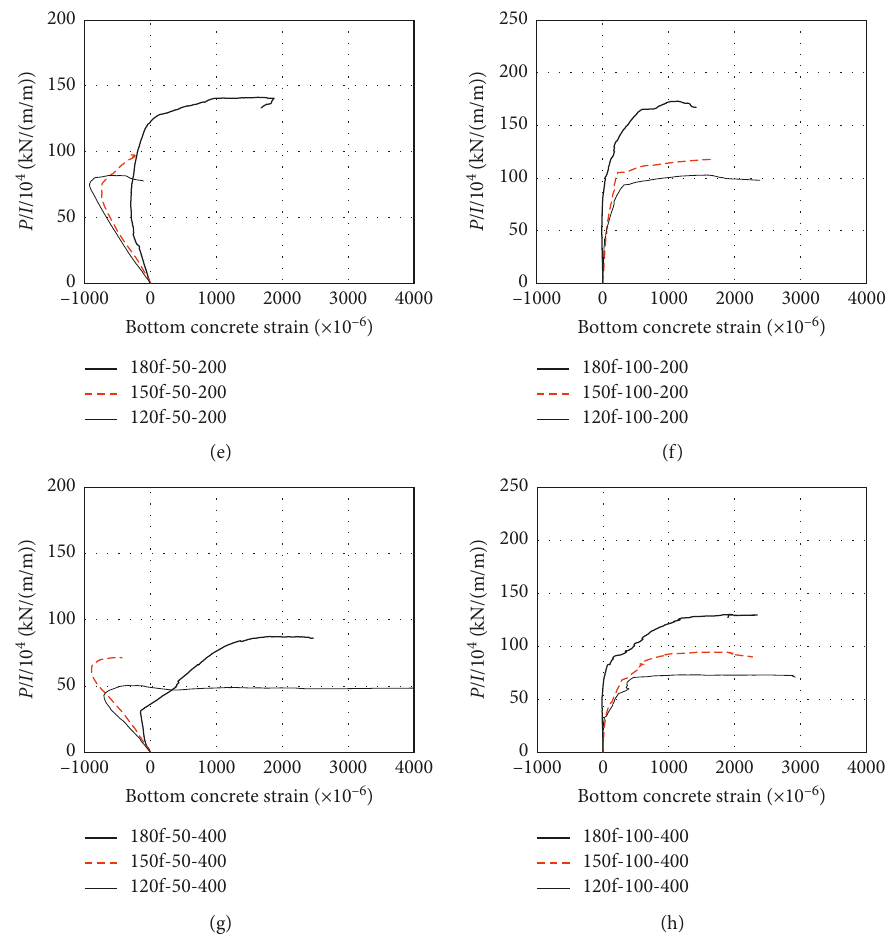
Figure 8: Load-concrete strain curves at bottom of slab for the specimens. (a) Slab thickness, stud spacing (50mm, 50mm); (b) slab thickness, stud spacing (100 mm, 50mm); (c) slab thickness, stud spacing (50mm, 100mm); (d) slab thickness, stud spacing (100mm, 100mm); (e) slab thickness, stud spacing (50mm, 200mm); (f) slab thickness, stud spacing (100mm, 200mm); (g) slab thickness, stud spacing (50mm, 400 mm); (h) slab thickness, stud spacing (50mm,